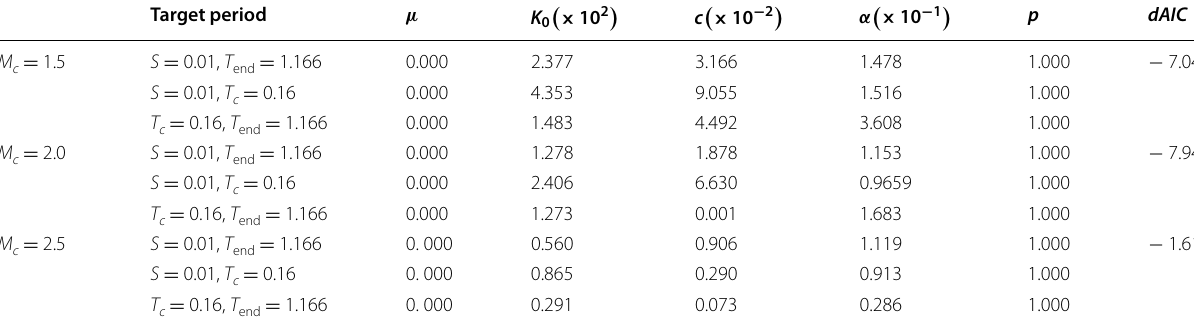
Single ETAS model (1) is fitted to the M6.5 aftershock sequence prior to the M7.3 mainshock. For each threshold magnitude, the first row shows the MLEs for the entire period ( S 0.01 days, T end 1.166 days) with AIC = = and the third row shows those for the post-change-point period ( T c